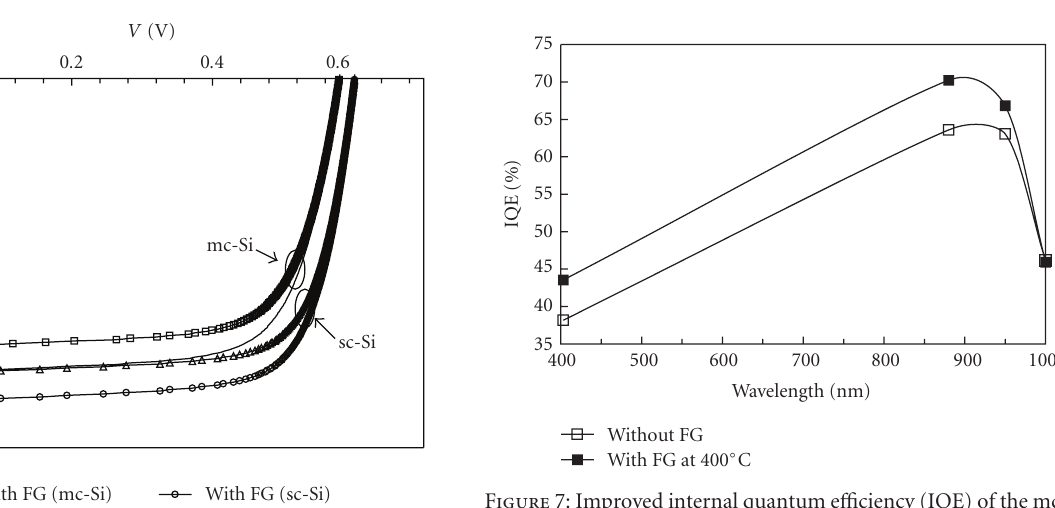
Figure 6: Improved energy conversion e ffi ciency ( η ) of sc-Si and mc-Si solar cells with/without di ff erent H 2 FG (for mixed gas ratios) treatment time.